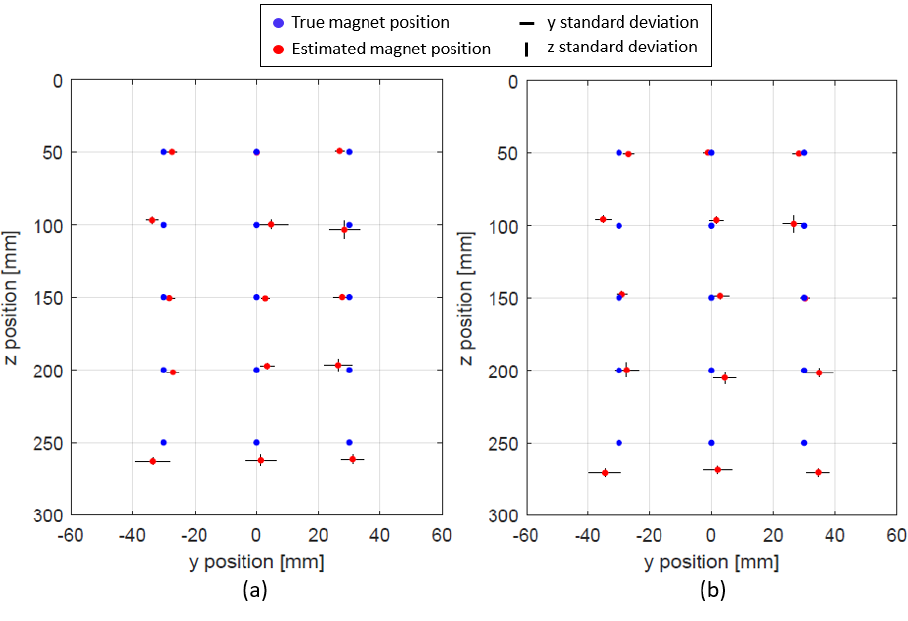
Figure 6. The average y and z position error and SD for L = ( a ) 80 mm and ( b ) 100 mm.